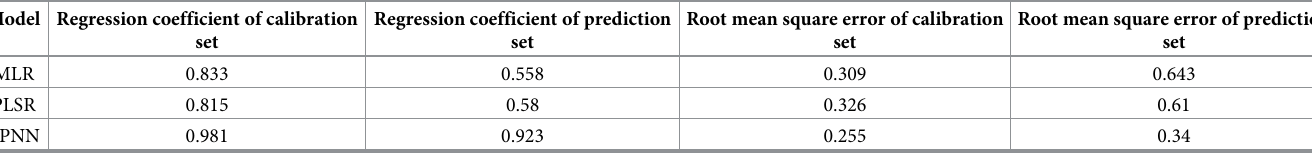
Table 4. Comparison of the prediction results of three models for bitterness.